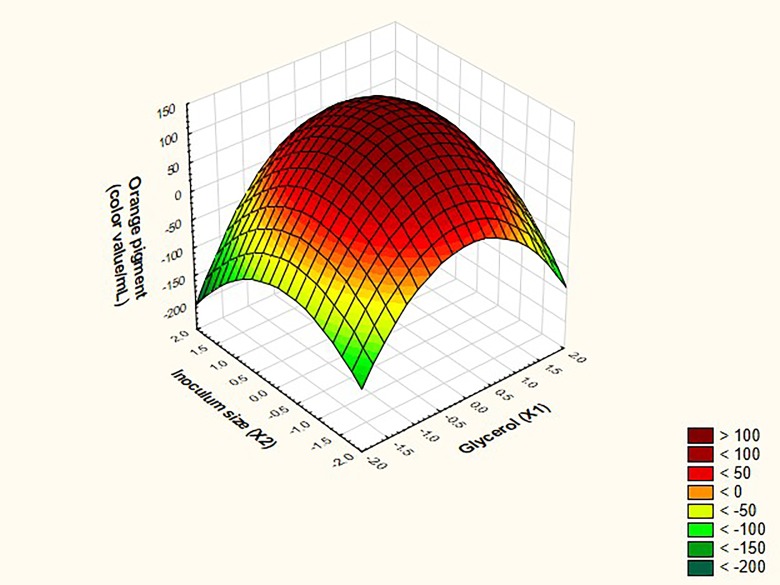
Three dimensional surface plots for the independent variables glycerol and inoculum size in relation to orange monascus pigments production.